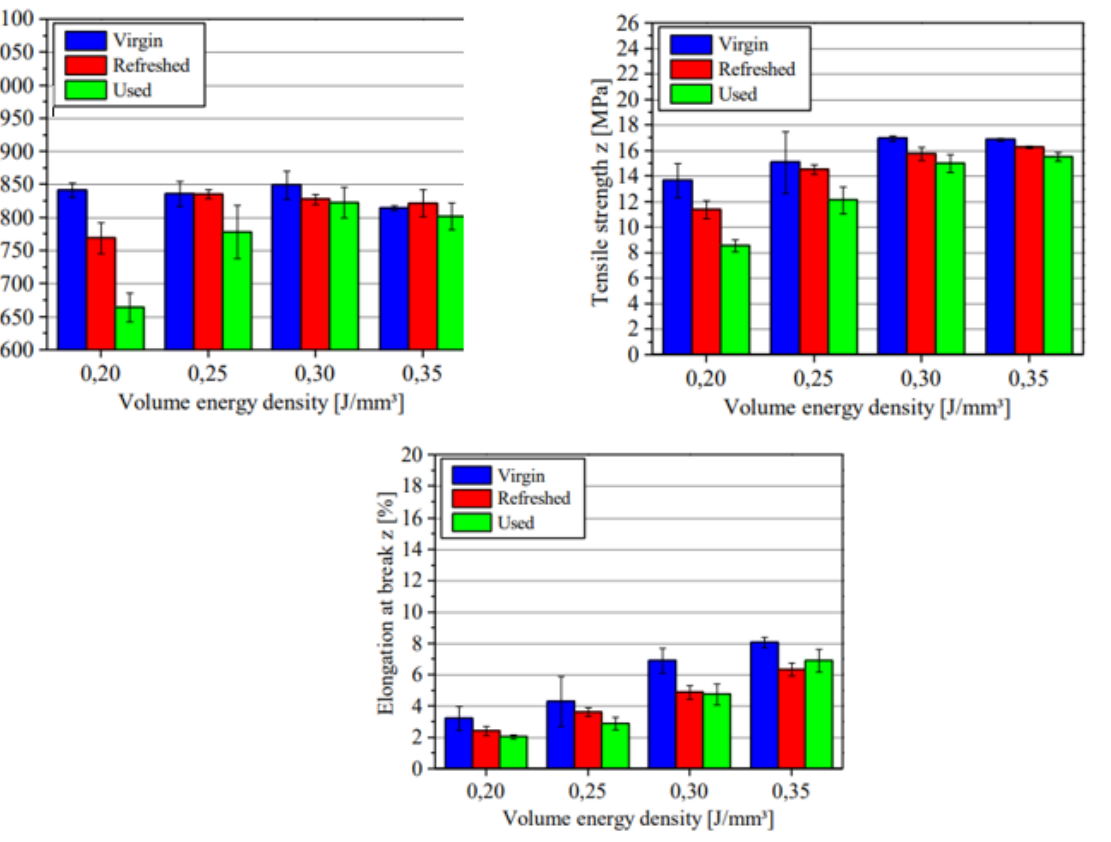
Figure 20. Effects of re ‐ use cycles on the mechanical properties of PP [20].